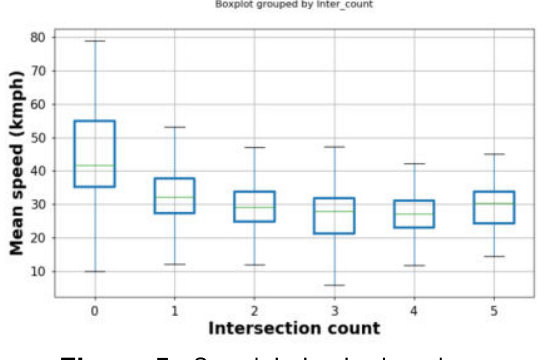
Figure 7. Speed behavior based on Intersection Density ( I d